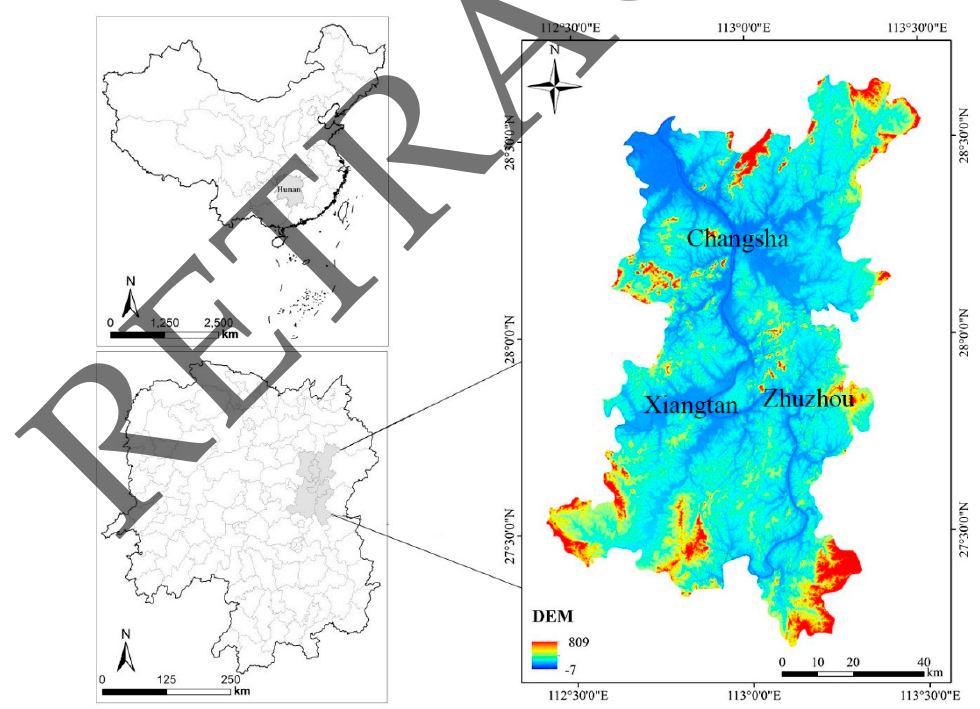
Figure 1. Location of the Changsha–Zhuzhou–Xiangtan area.